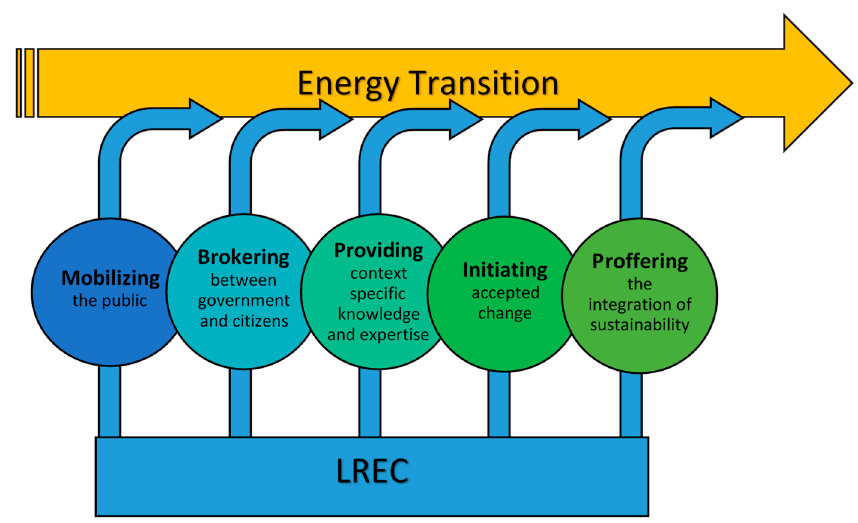
Figure 4. The five governance roles of LRECs for facilitating the energy transition (authors’ own).